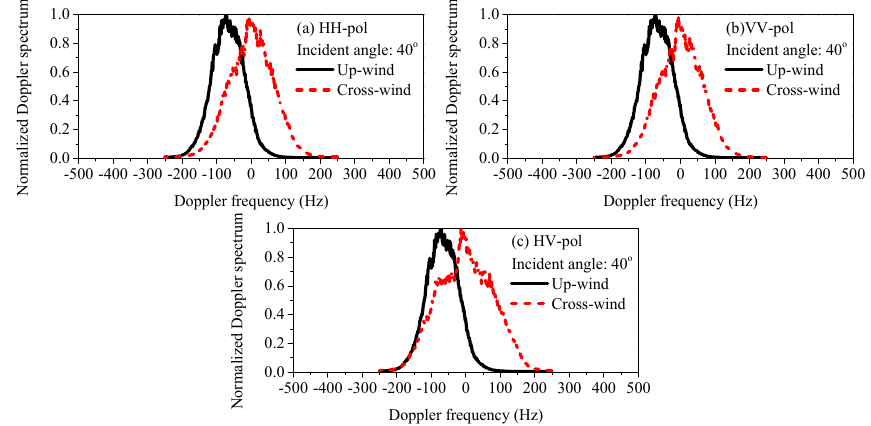
Figure 14. Comparison of Doppler spectrum at Ka-band for different wind directions and polarizations. ( a ) HH polarization; ( b ) VV polarization; ( c ) HV polarization.